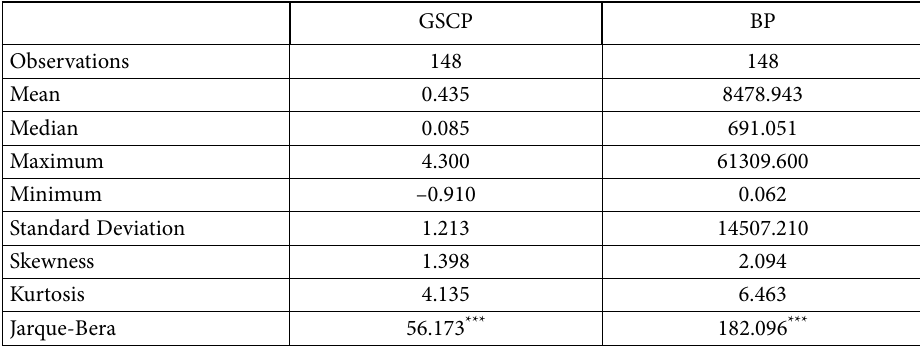
Table 1. Descriptive statistics for GSCP and BP (source: authors’